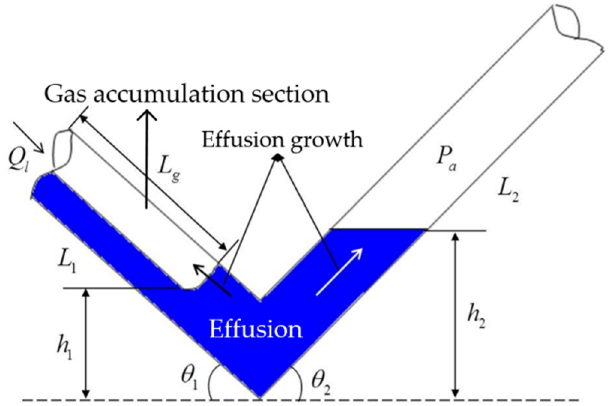
Figure 3. Schematic diagram of the accumulated gas compression model.